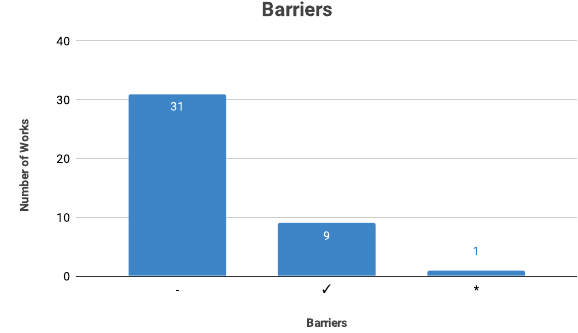
Figure 13. Number of works that generated levels with barriers. The ‘*’ oc­ currences mean that the paper was not clear in the respective classification.